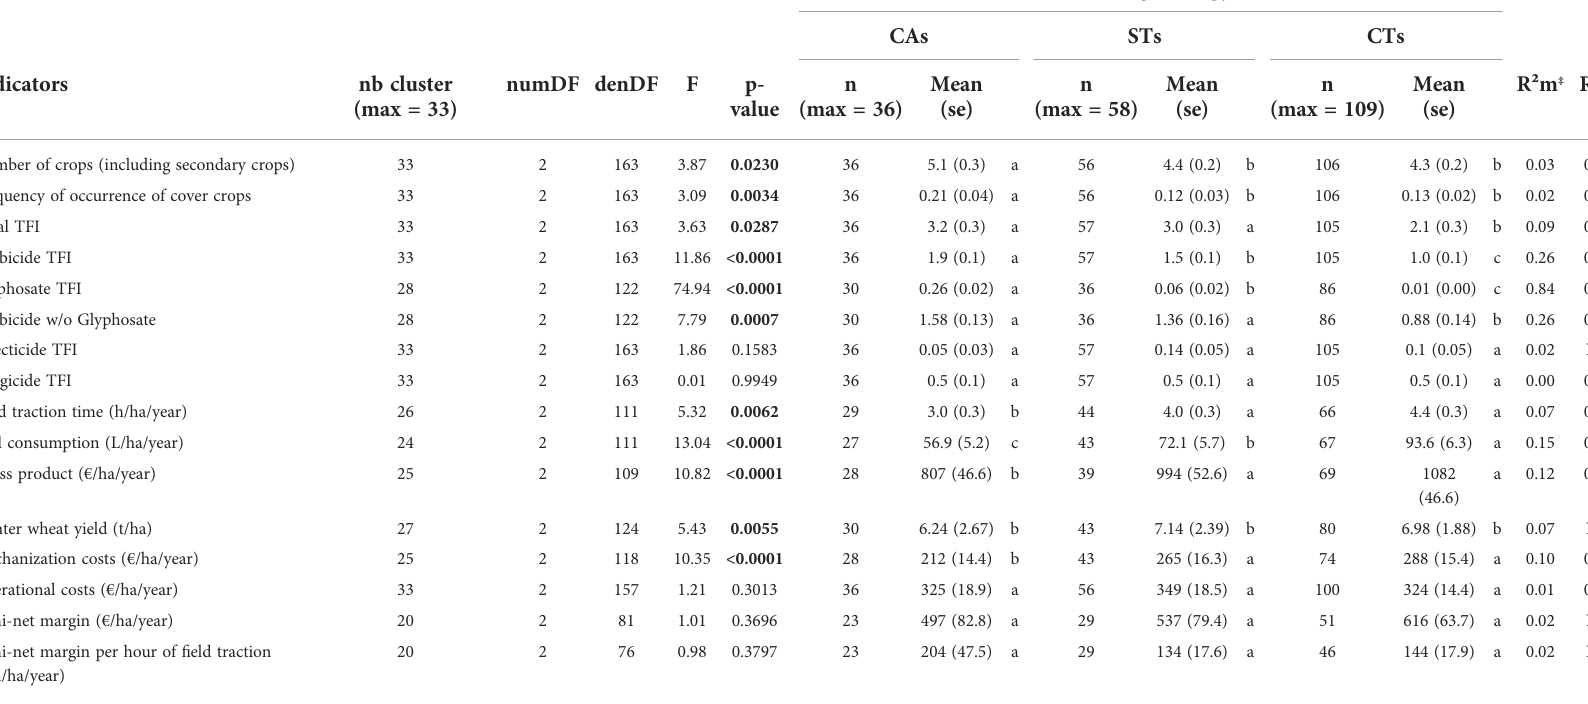
TABLE 1 Comparison of indicators between conservation agriculture systems (CAs) and their reference conventional tillage (CTs) and super fi cial tillage (STs) based systems, while accounting for production situation